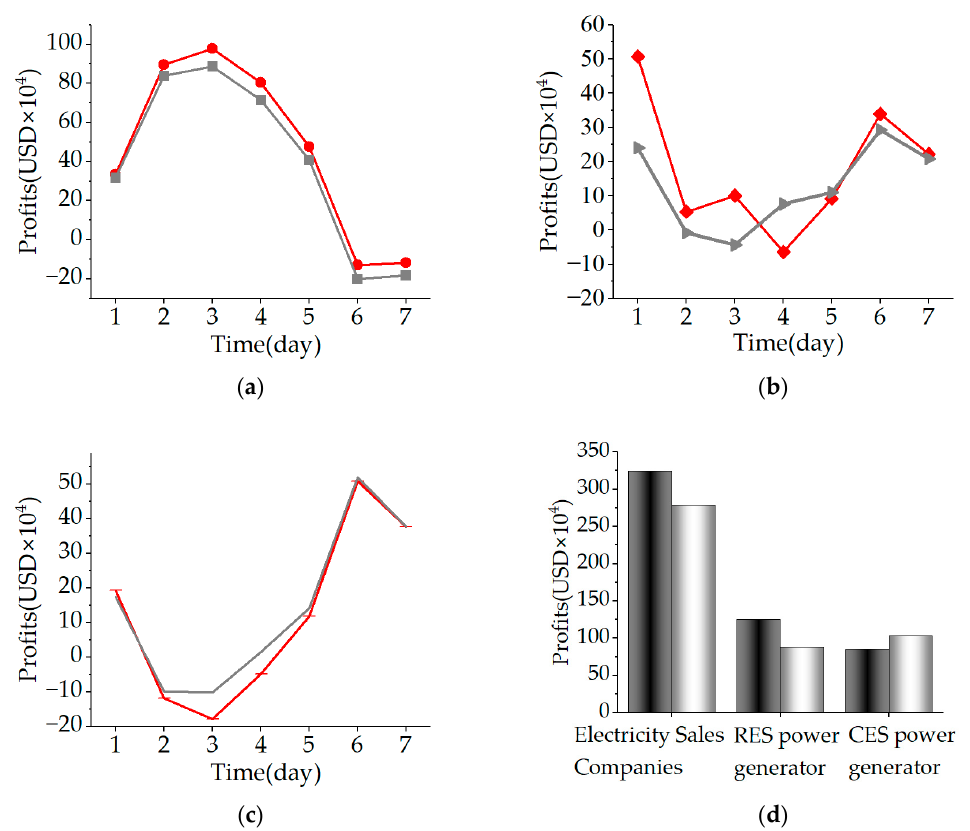
Figure 6. The profit of each subject of power trading: ( a ) electricity sales company; ( b ) RES power generator; ( c ) CES power generator; ( d ) the total profit of each subject of power trading in seven trading days.